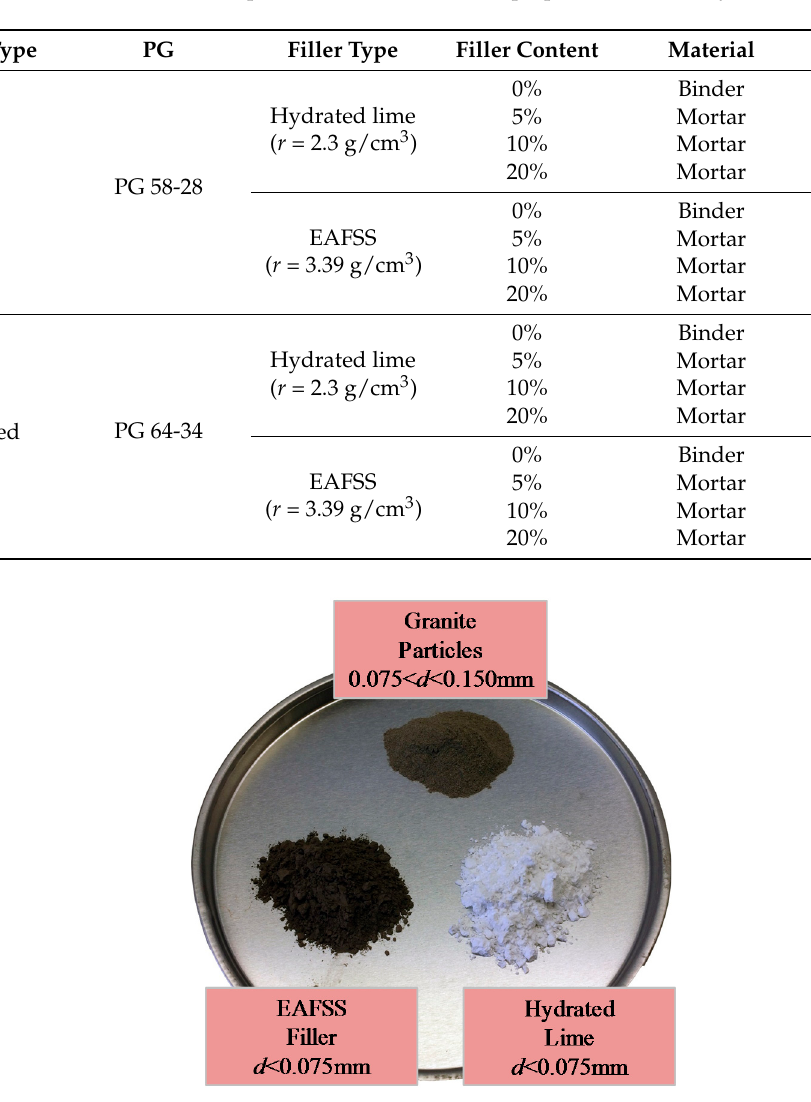
Table 1. Asphalt binders and mortars prepared in this study.